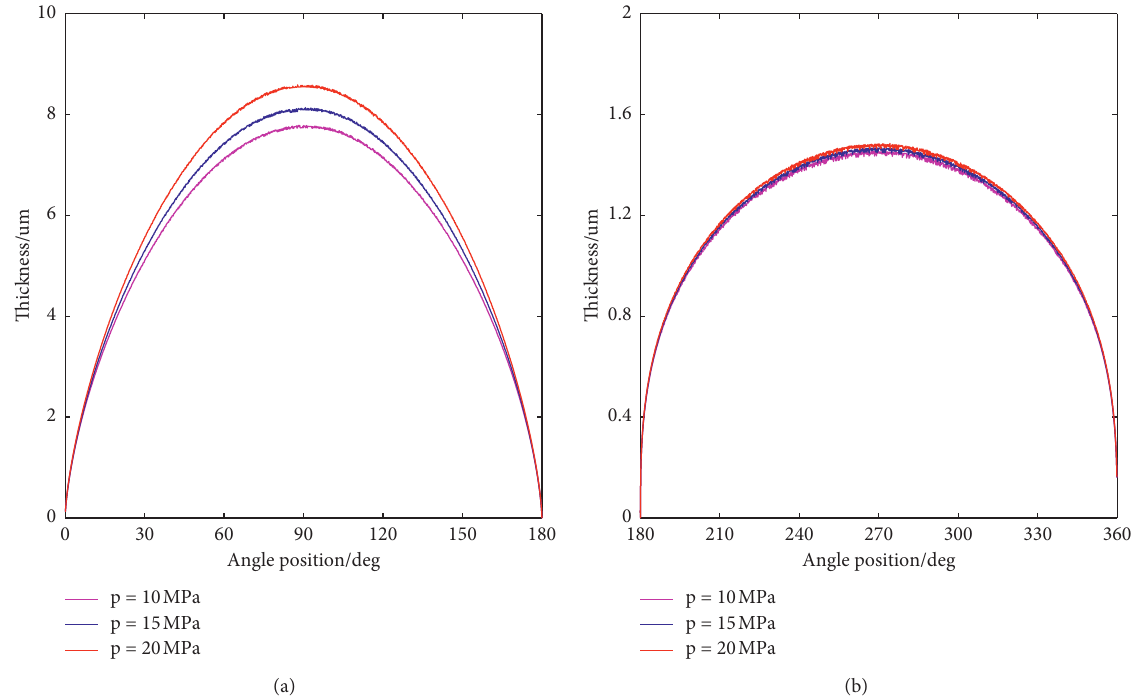
Figure 9: The minimum thickness at different pressure. (a) The discharge region; (b) the suction